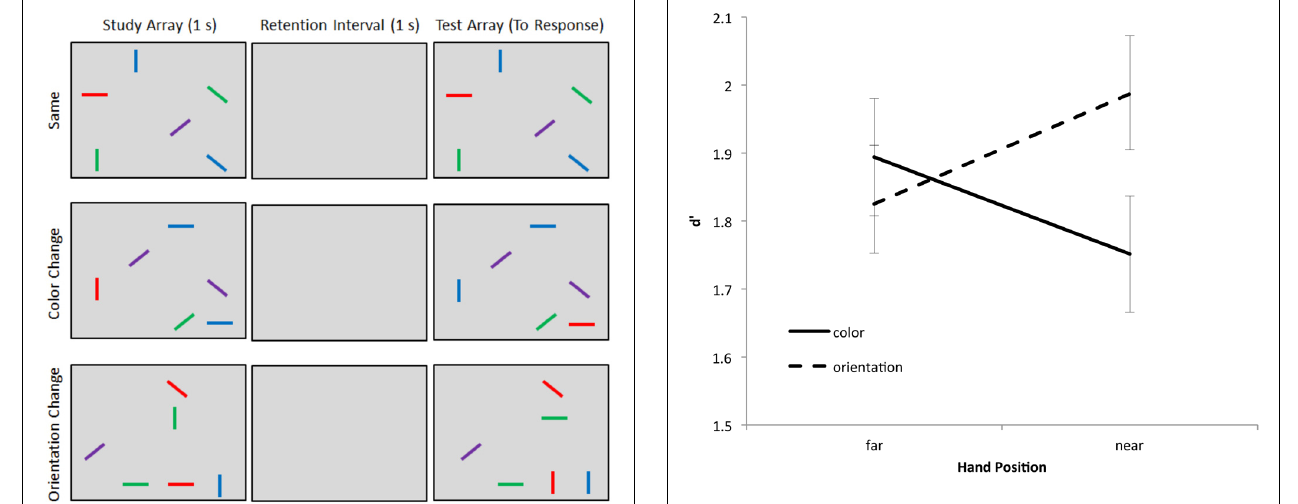
FIGURE 2 | Change detection performance as a function of hand position and change type. The main effects of hand position [ F (1,60) = 1.75, p =